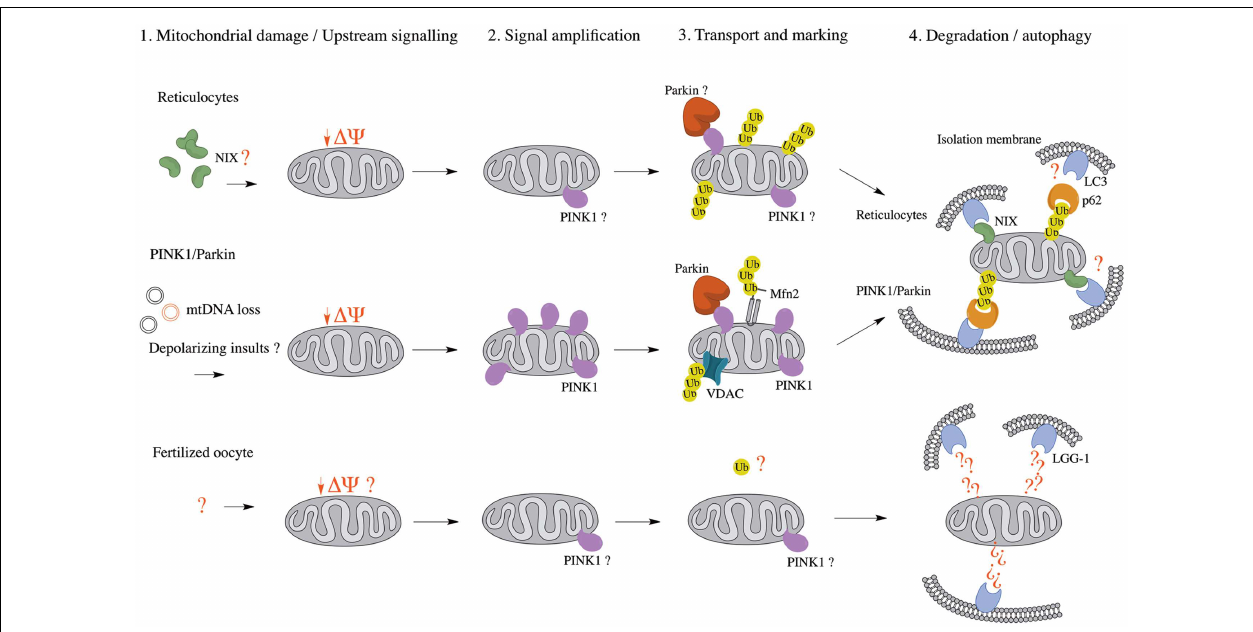
autophagic degradation. (4) Mitochondria are enveloped by isolation membranes and delivered to autophagosomes. ∆ψ , mitochondrial membrane potential; LC3, microtubule-associated protein 1 light chain 3; LGG-1, LC3, GABARAP, and GATE16 family 1; Mfn2, mitofusin 2; mtDNA, mitochondrial